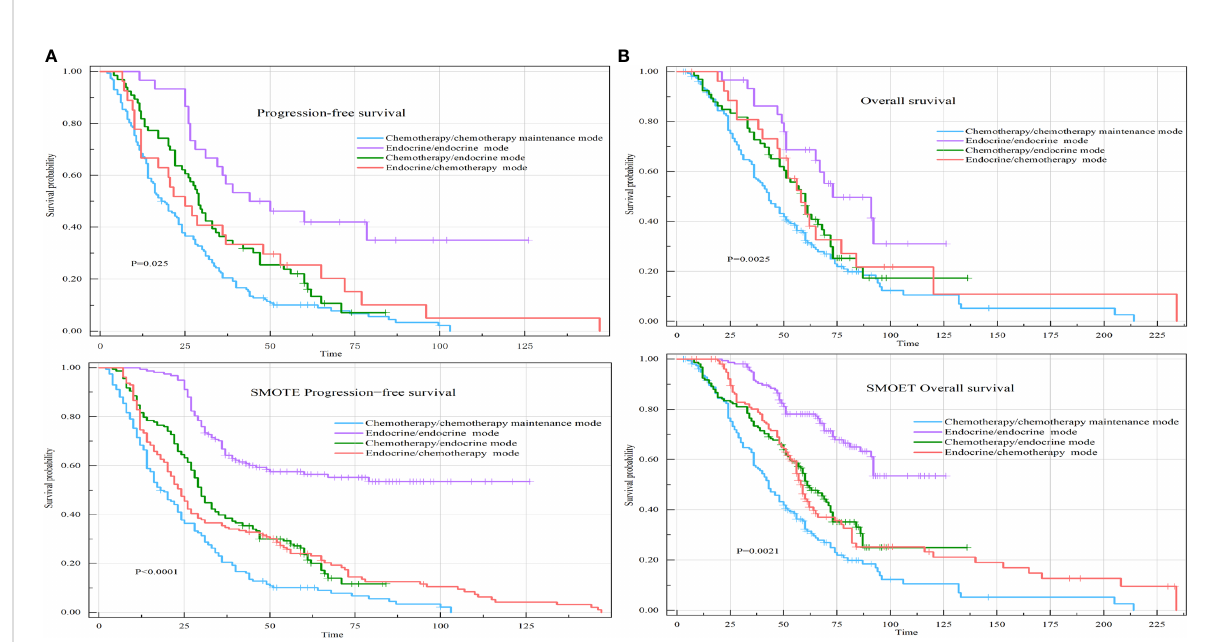
FIGURE 6 PFS and OS of the four different fi rst-line/second-line treatment modes. (A) Kaplan – Meier curve of PFS in the four different fi rst-line/second- line treatment modes. (B) Kaplan – Meier curve of OS in the four different fi rst-line/second-line treatment